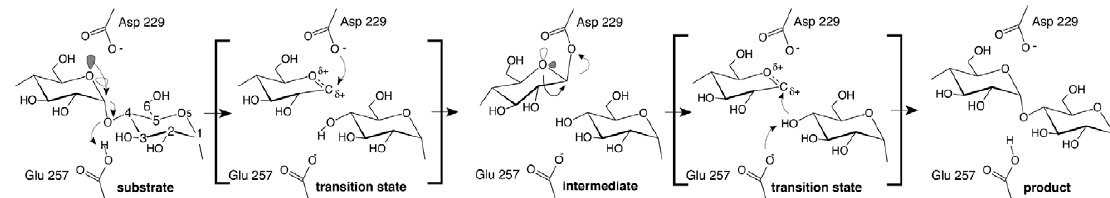
Figure 3 . Mechanism of the α -retaining α (1-4) glycosidic bond cleavage used by the α -amylase family. Adapted from [149].